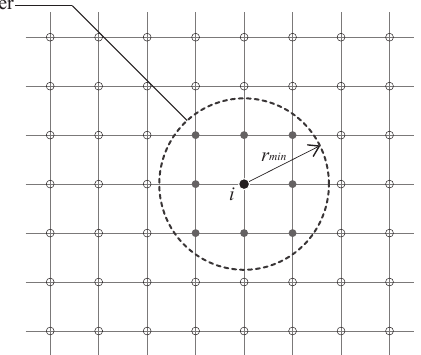
Figure 4. A 3 × 3 filter for i -th column inside circular